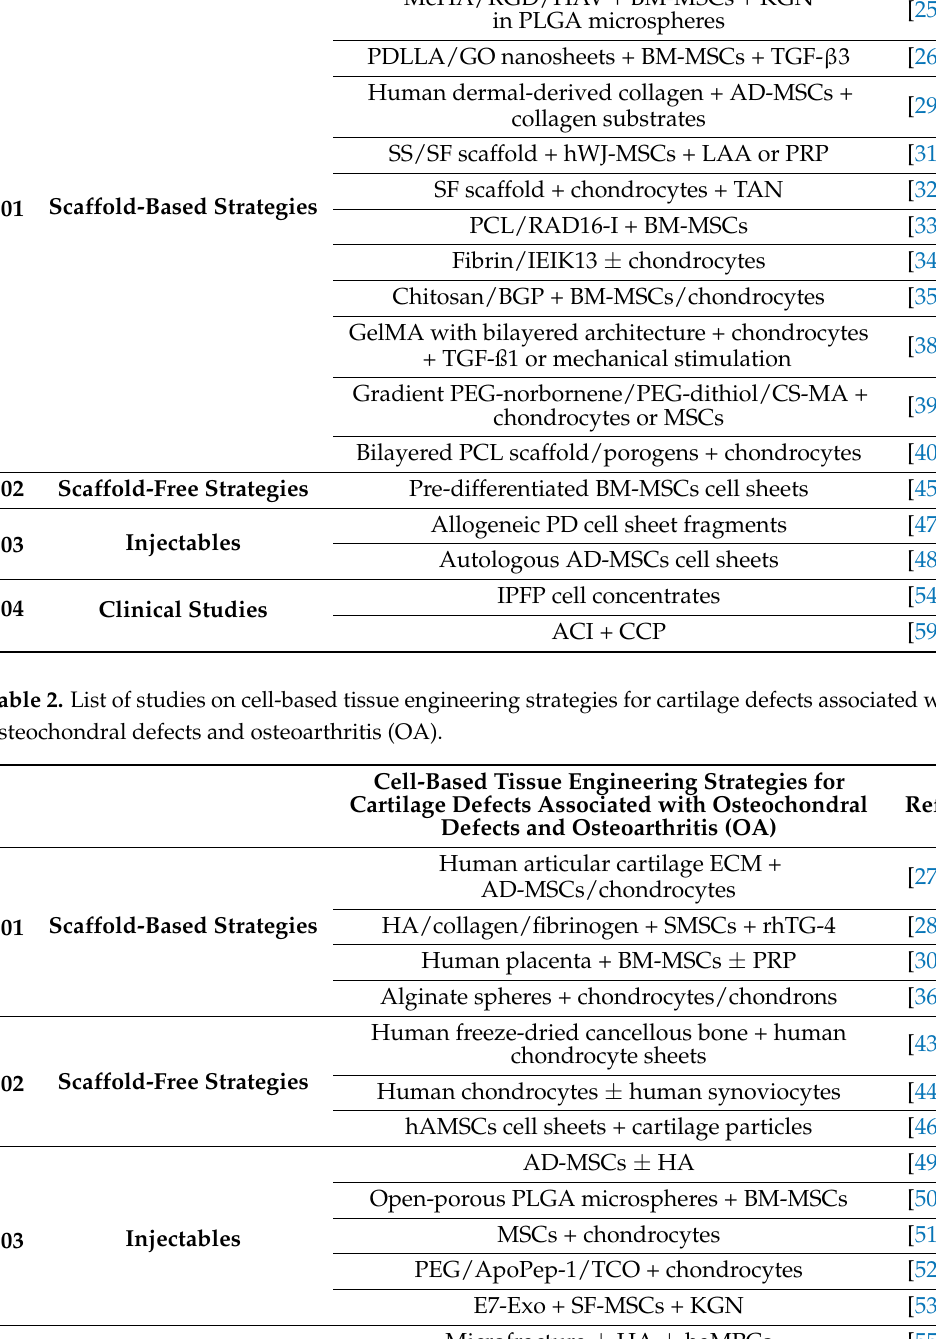
Cell-Based Tissue Engineering Strategies for Cartilage Defects